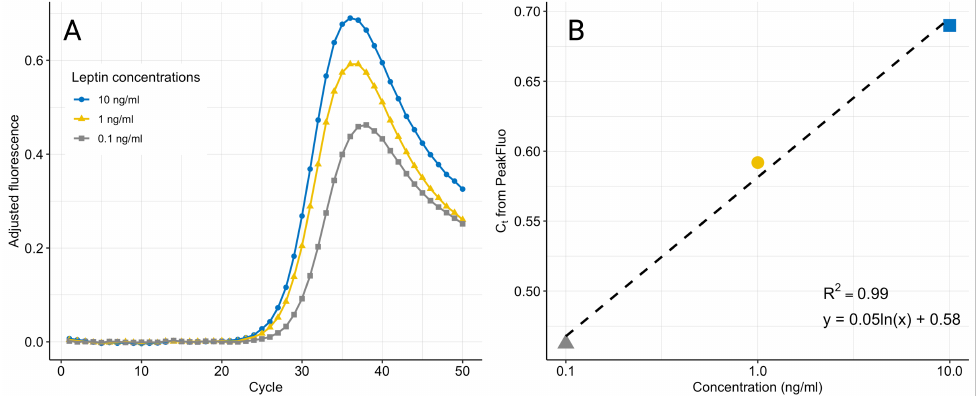
Figure 7. qPCR fluorescence amplification curves after removal of BackgroundFluorescence and ProcessFluorescence ( A ). The noise-adjusted signals decrease at higher cycles as the amplification curves reach a common plateau. The maximum fluorescence at the peak is used to generate the standard curve ( B ). The data are an example from one experiment using three replicates for each concentration.